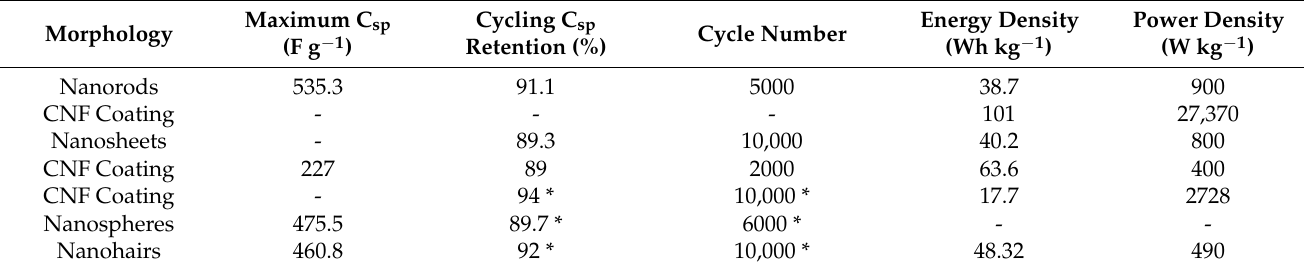
Table 3. V 2 O 5 morphology and electrochemical performances of V 2 O 5 /carbon nanofiber composite electrodes for superca- pacitor